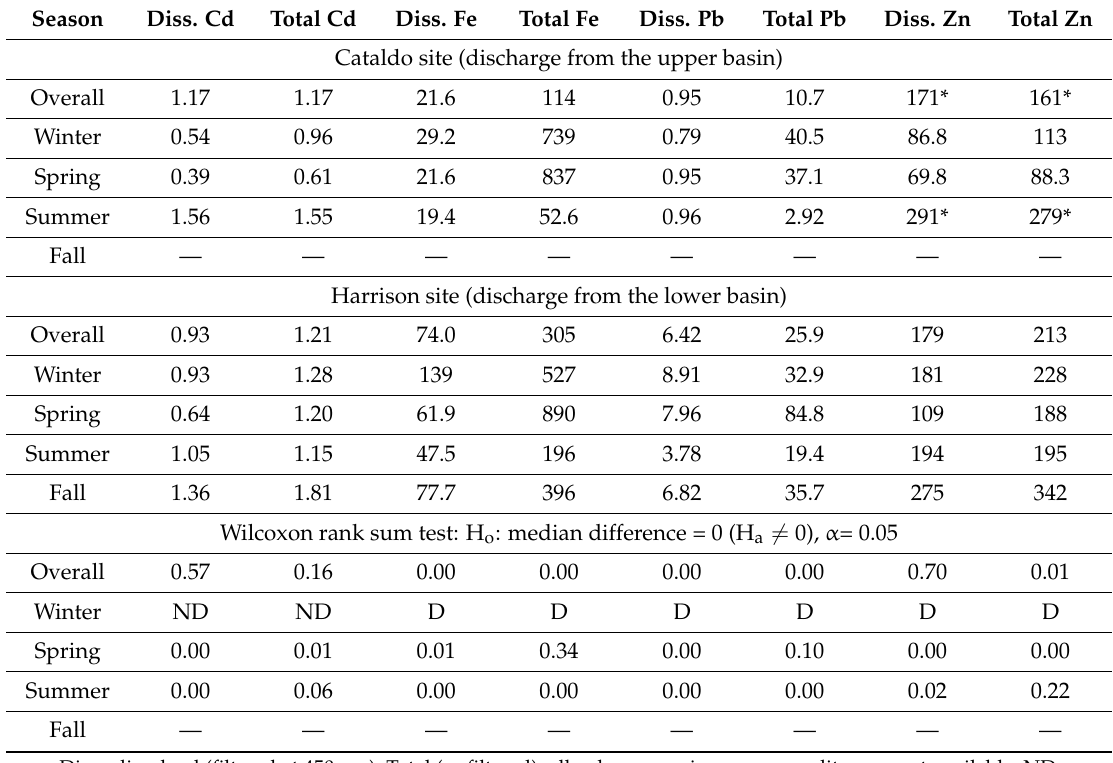
Table 2. Median dissolved and total metal concentrations at Cataldo and Harrison and Wilcoxon rank sum test p -values for the overall data and seasonal data for comparison of the sample populations between basins,